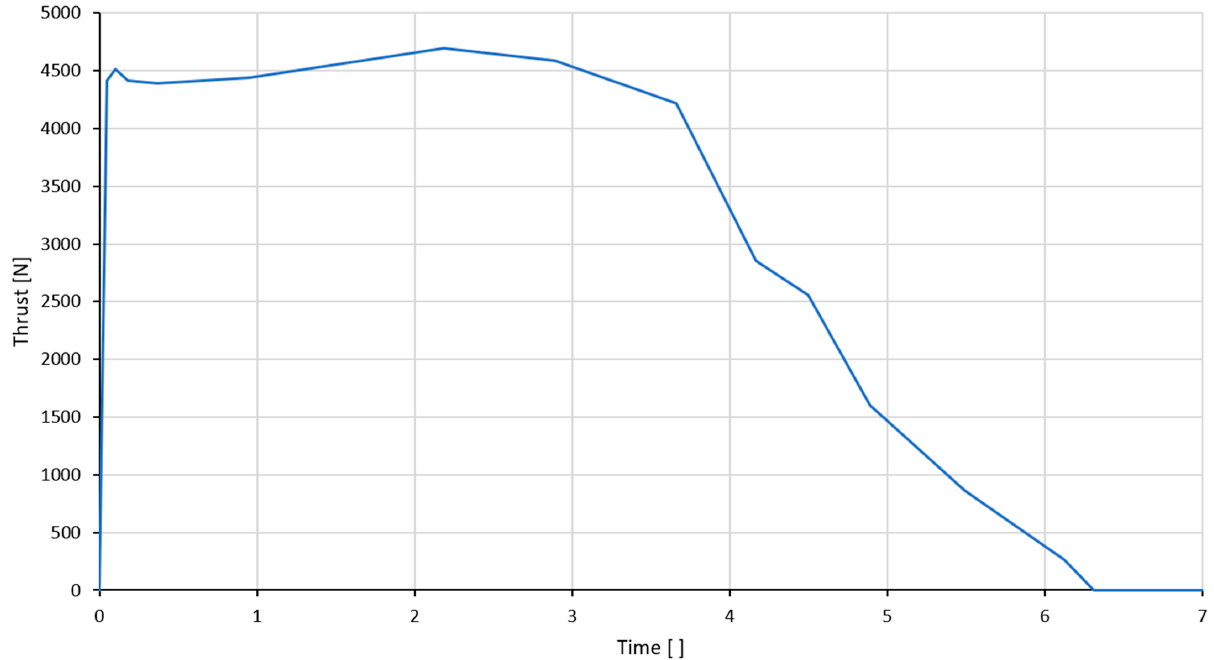
Figure 21. Cesaroni O3400 “Imax” thrust curve.